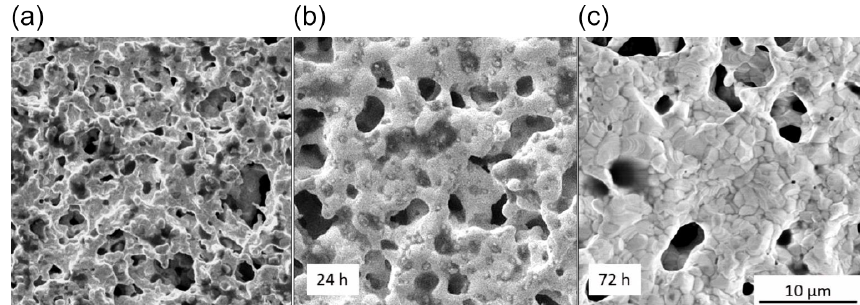
Figure 7. SEM image of a screen-printed substrate with a platinum thick film paste (a) before, (b) after 24h, and (c) after 72h of thermal ageing at 1000 ◦ C.